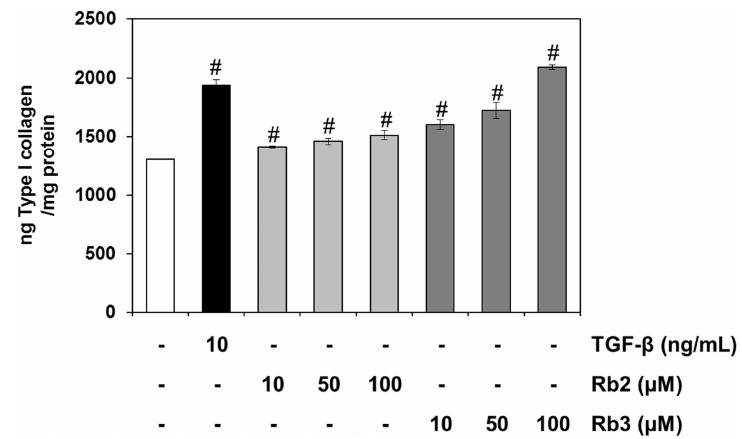
Figure 3. Effects of two main ginsenosides, Rb2 and Rb3, on collagen synthesis in human dermal fibroblasts. Human dermal fibroblasts were cultured in 24-well plates. Human dermal fibroblasts were treated with or without TGF- β and/or ginsenosides (Rb2, Rb3) at the indicated concentrations for 48 h at 37 °C. The culture supernatants were harvested and measured with a sandwich immunoassay kit. Data are mean ± standard deviation. # p < 0.01 compared with the vehicle-treated group ( n = 3). The results were confirmed by five independent experiments.